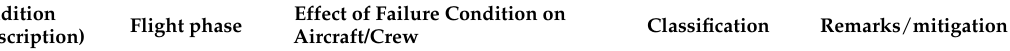
Table A5. ADS FHA for